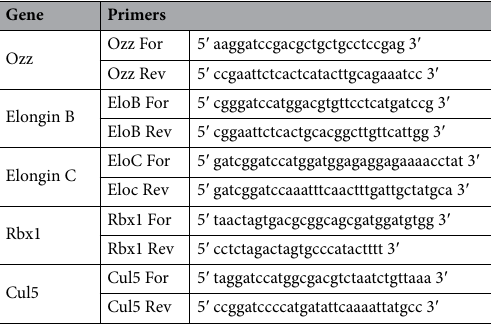
Table 1. Primers used for the generation of CRL5 Ozz